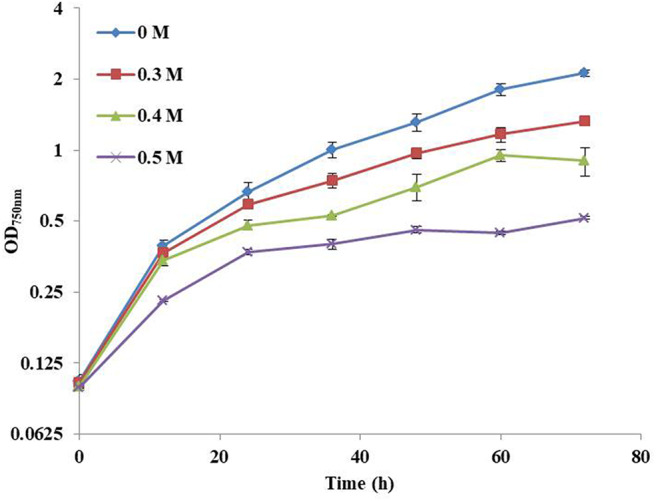
Growth curves of Syn2973 in BG-11 medium under different concentrations of NaCl (0 M, 0.3 M, 0.4 M, and 0.5 M).